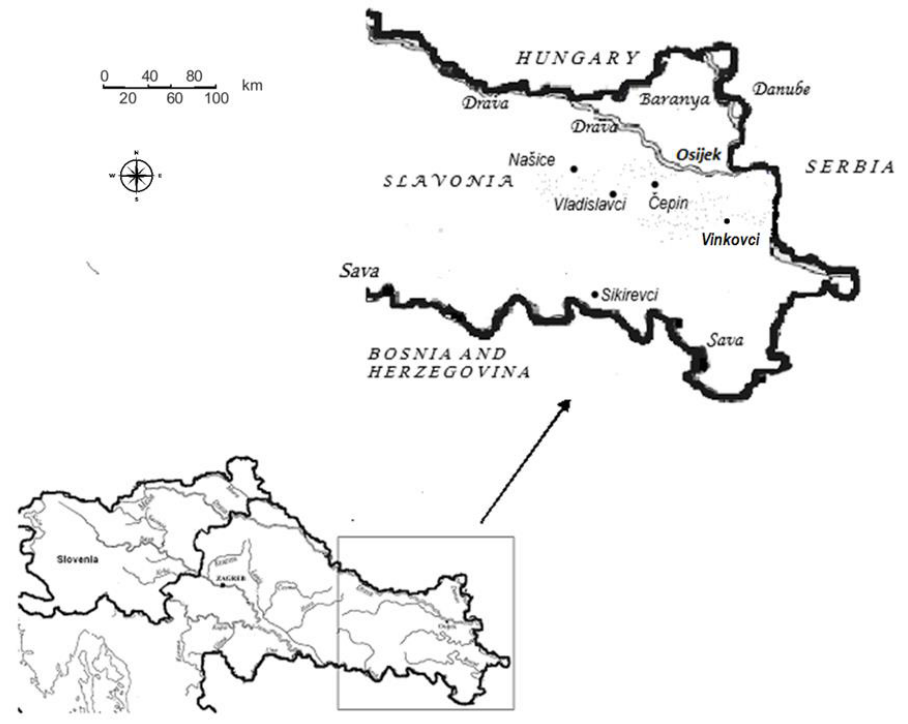
Figure 1. Locations of sampling and the position of the main rivers (Danube, Drava, Sava) in Croatia.